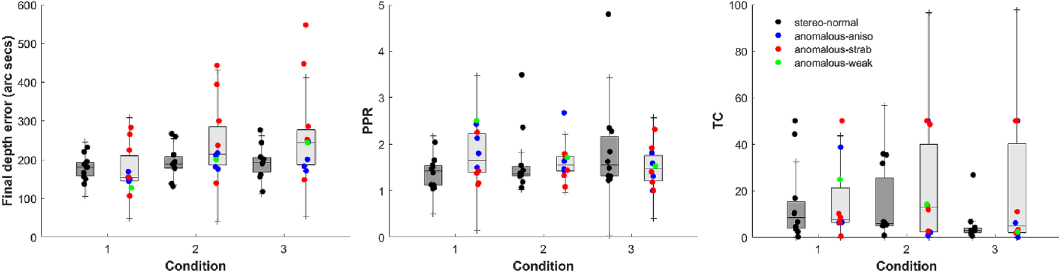
Figure 5. Box plots of DartBoard in-game performance accuracy, from the exponential fits: Final depth error, PPR, and time constant. Medians and interquartile ranges for each group and condition considered. Depth error values in seconds of arc.